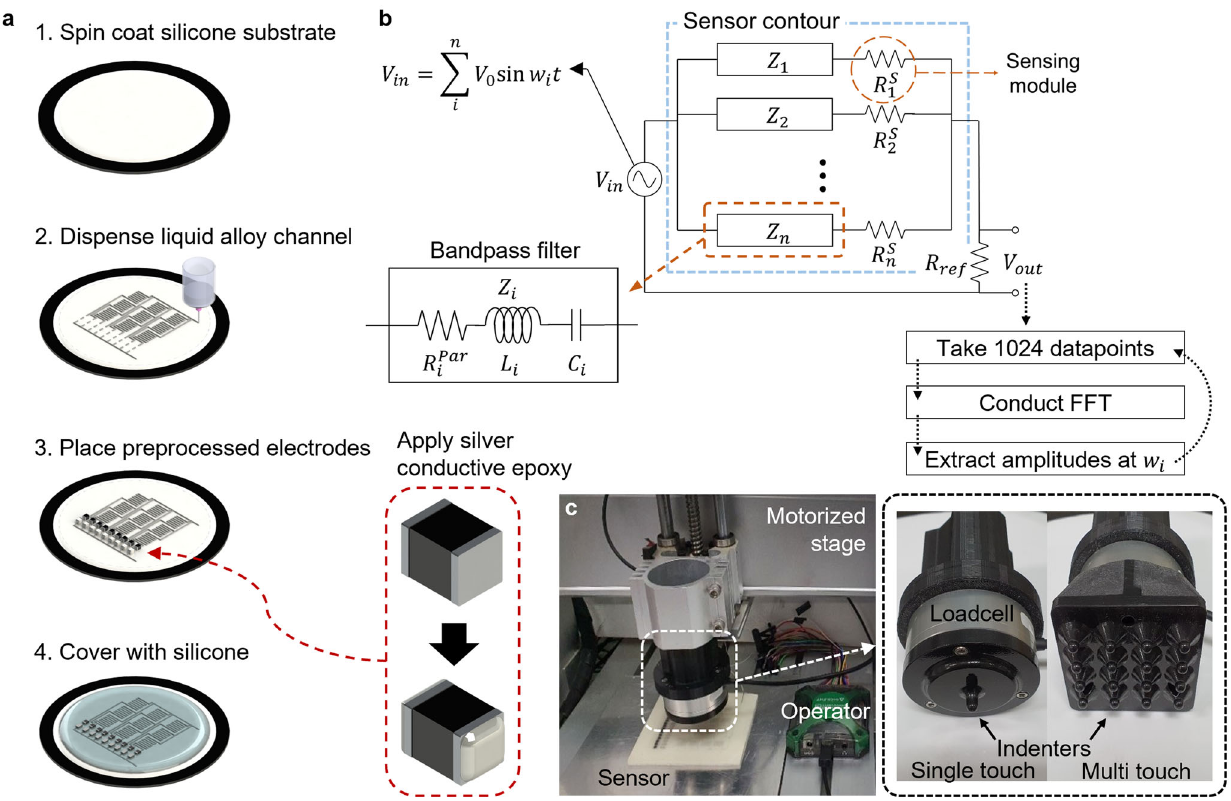
Fig. 5 Fabrication process, sensor circuit and test setup. a Fabrication process of the proposed sensor array. b Description of the sensor circuit with a data processing protocol. c Test setup for the sensor characterization with the photos of the indenters used for single- and multi- touch sensing